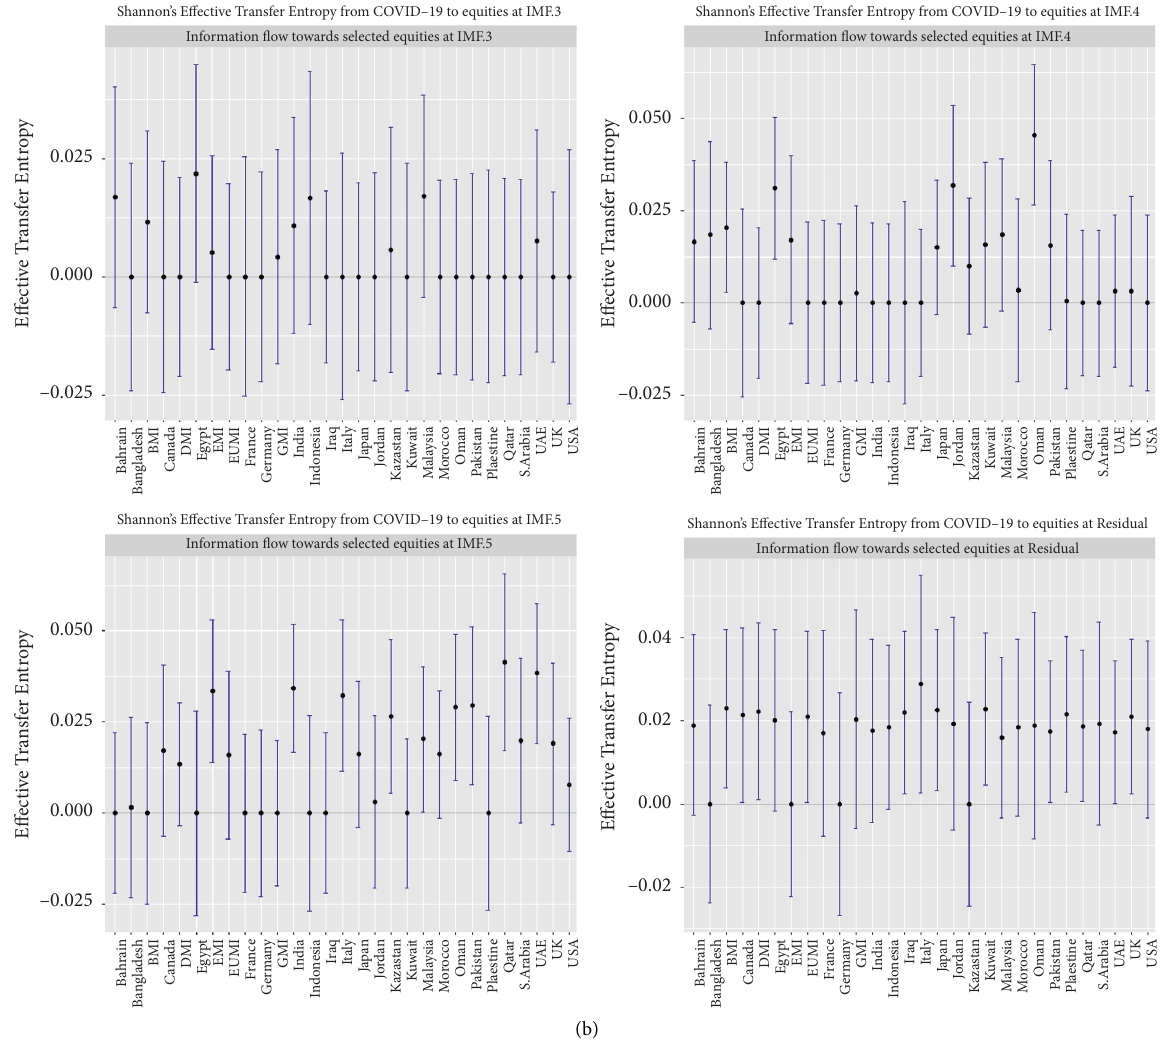
Figure 4: Composite and frequency-domain Shannon ETEs from